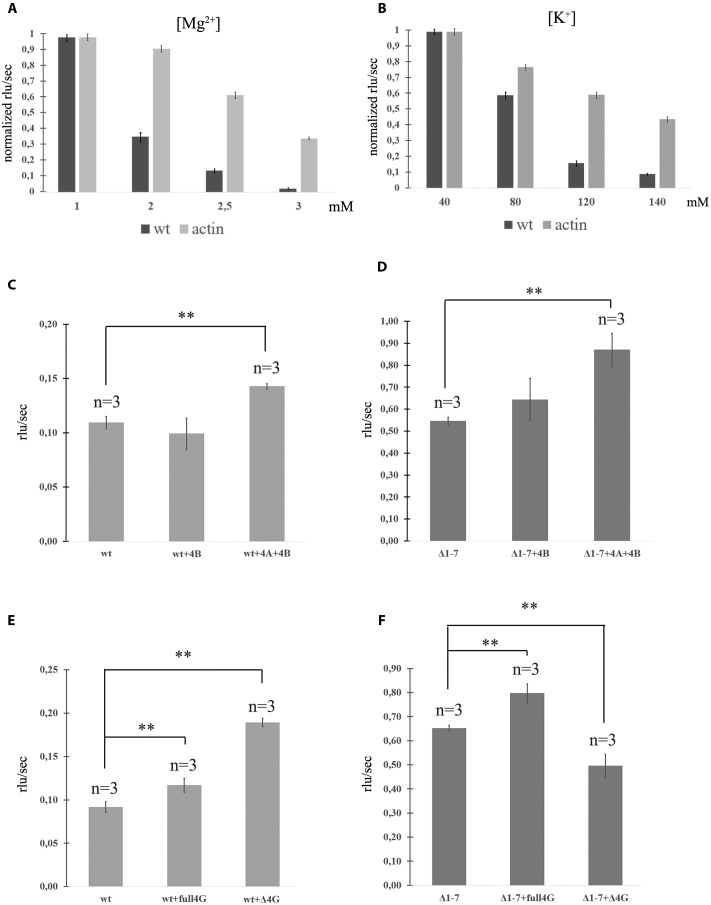
Translation of mRNAs with wild-type and mutated PKMζ 5′UTR in RRL.
(A) Rates of translation of mRNAs containing PKMζ or actin 5′UTRs in different concentrations of Mg2+. (B) Rates of translation of mRNAs containing PKMζ or actin 5′UTRs in different concentrations of K+. (C,D) Rates of translation of mRNA containing wild-type (C) or mutated Δ1–7 (D) 5′UTR of PKMζ in the presence of eIF4B and eIF4A. (E,F) Rates of translation of mRNAs containing wild-type (E) or mutated Δ1–7 (F) 5′UTRs of PKMζ in the absence or presence of eIF4G and its truncated form Δ eIF4G. The error bars represent the standard deviation, asterisks indicate a significant difference determined by a t-test, ∗∗P < 0.01 (n = 3). Rlu, related luminescence units.